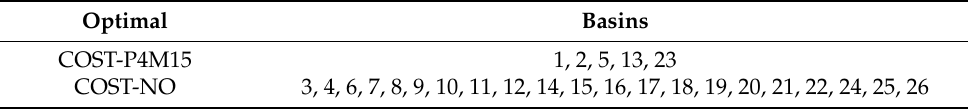
Table 13. The results of each basin about the optimal coefficient. Optimal